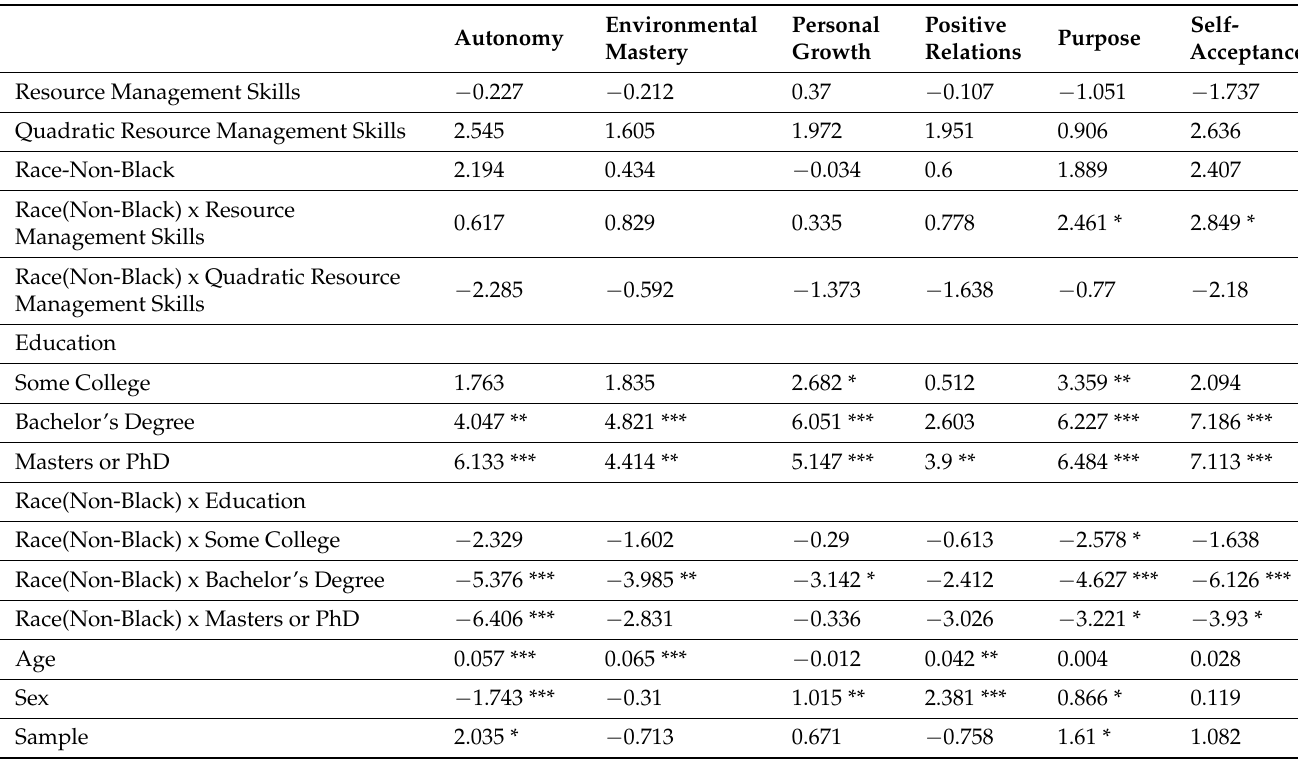
Table A6. Resource Management Skills and Well-being.